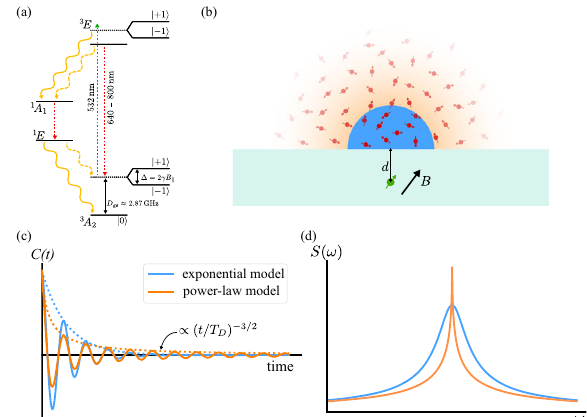
Fig. 1 NV level scheme and power-law model. ( a ) Level scheme of the NV centre. ( b ) The NV centre is located at a depth d below the diamond surface. In the standard diffusion model a hemisphere sensing volume (blue) of radius ~ d is considered, in which the nuclei interact with the NV centre. Alternatively, we accurately take into account the 1/ r 3 dependence of the dipole – dipole interaction. The colour intensity of the orange hemisphere indicates the interaction strength of the nuclear spins (red) with the NV centre. ( c ) Decay of the auto-correlation according to the exponential and the power- law model. With the accurate dipole – dipole model, decay is (nearly) exponential for short times ( t ≪ T D ) and a power-law for t ≫ T D with T D the characteristic diffusion time. ( d ) Power spectrum of the NMR signal. The power-law model shows a distinct, sharp peak whereas the exponential model resembles a Lorentzian